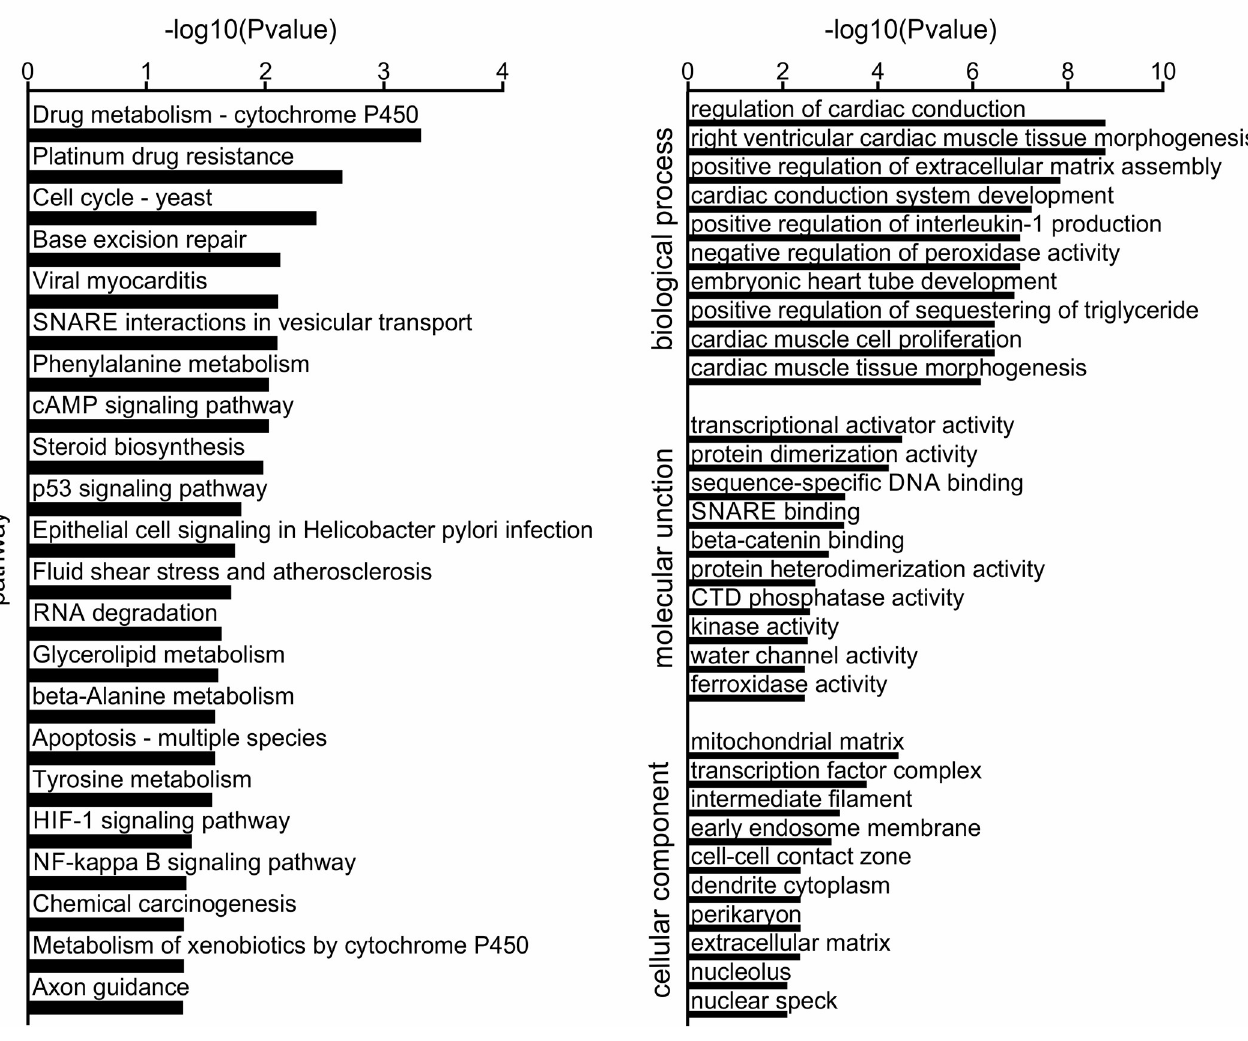
Fig 5. Functional enrichment of genes related to different methylation levels. methylation changes, such as intermediate filament ( LOC105240942 and LOC100465932 , hypermethylated), membrane raft ( RRK2 , LOC100476759 , and GNAI1 , hypermethylated), midbody ( KIF20B , GNAI1 , and ASPM , hypermethylated). For molecular function, the DMGs were enriched in 181 terms, among which 29 were associated with cataract. 16 of the 29 terms had DMGs with same directional changes in one same term, such as structural constituent of cytoskeleton ( LOC100473181 and TUBD1 , hypermethylated), SNARE binding ( STX19 and LRRK2 , hypermethylated), beta-catenin binding ( SOX9 and SOX17 , hypomethylated), calmod- ulin binding ( EEA1 and MIP , hypermethylated). For biological process, the DMGs were enriched in 690 terms, 219 of which were linked with cataract. 182 of the 219 terms had DMGs showing same directional changes, such as cardiac muscle tissue development ( NKX2-5 , hypermethylated), BMP signaling pathway ( ACVR2A , TMEM100 , and NKX2-5 , hypermethy- lated), cellular metabolic process ( PDP1 and PDK1 , hypermethylated), cholesterol metabolic